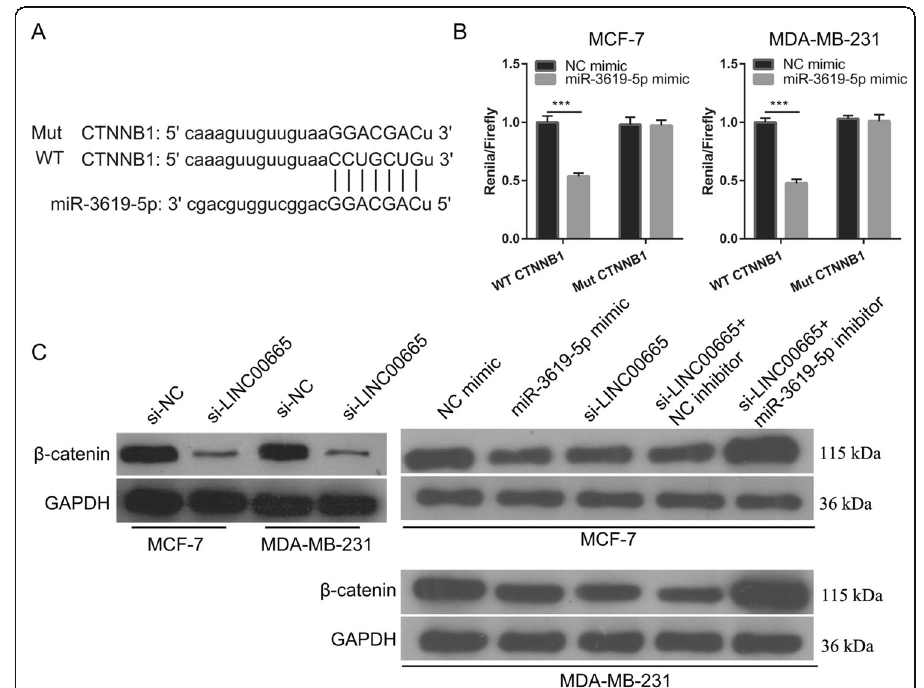
Fig. 8 Effect of LINC00665/miR-3619-5p expression on β -catenin expression in breast cancer (BC) cells. a Potential binding sites between CTNNB1 and miR-3619-5p. b Luciferase reporter assay showing that the CTNNB1 3 ′ - untranslated region has a direct binding site for miR-3619-5p. c Western blot showing LINC00665 knockdown and that miR-3619-5p overexpression inhibited expression of β catenin (encoded by CTNNB1 ). Simultaneous knockdown of LINC00665 and miR-3619-5p promoted β -catenin expression in MCF-7 and MDA-MB-231